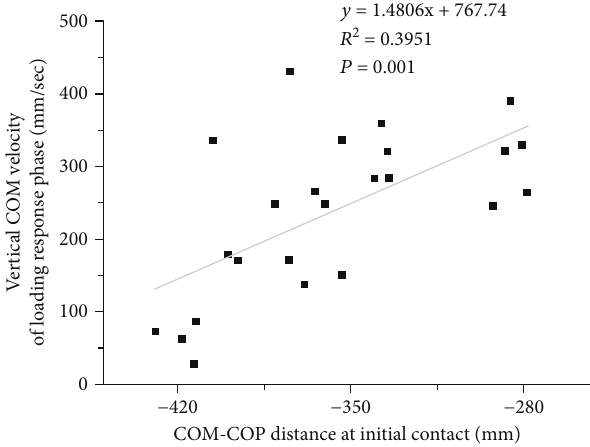
Figure 4: Relation between vertical COM velocity and COM-COP distance. Scatter plot for the vertical COM velocity of the loading response phase versus the COM-COP distance at the initial contact. The regression analysis showed that the COM-COP distance at the initial contact was signi fi cantly positively correlated with the vertical velocity of the COM. Linear regression lines and R 2 values are provided for the data of 14